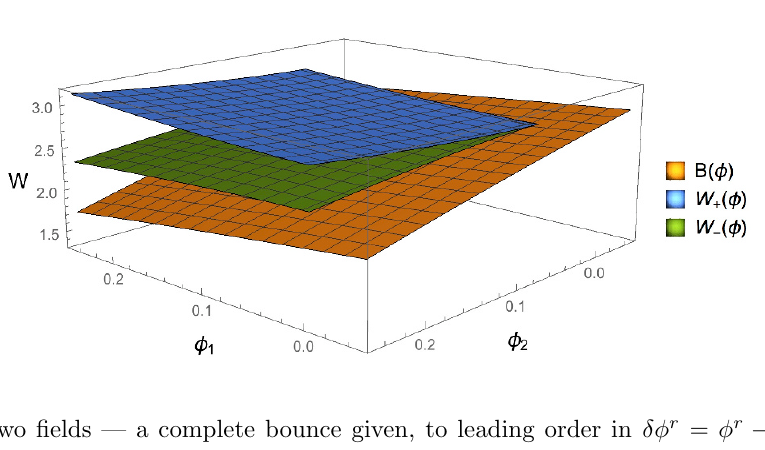
Figure 4 . The superpotential (3.60) gives rise, to leading order in ( (cid:30) r (cid:0) (cid:30) r depicted above. In (cid:12)gure (a) the green arrows correspond to the gradient of the lower branch of W ( (cid:30) ) depicted in (cid:12)gure 3, the choice of a negative sign in (3.60). Figure (b) represents the gradient of the upper branch from (cid:12)gure 3, a positive sign in (3.60). Each (cid:13)ow line goes back along itself close to this complete bounce.